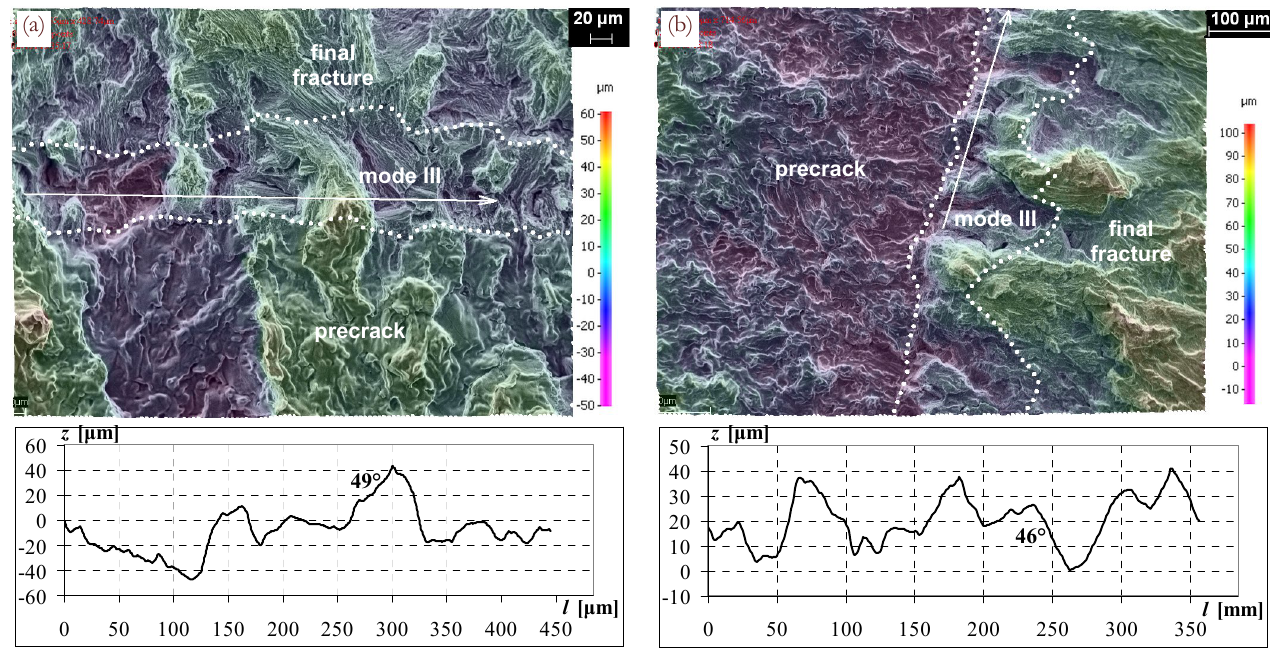
Figure 3: Mode III in ferritic-pearlitic steel, cylindrical shear specimen (a), torsion specimen (b). The white arrow defines the profile showed below and is parallel to the applied shear